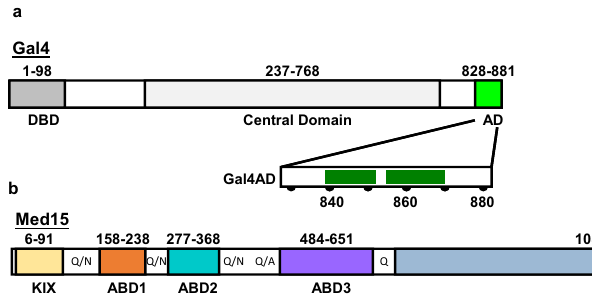
Fig. 1 Gal4 AD is an IDR that interacts with Gal15 ABDs. a Gal4 consists of a DNA binding and dimerization domain (DBD), a central domain (CD), and a primary activator domain (AD). The expanded view of the AD highlights key hydrophobic Regions 1 and 2 (residues 840 – 851 and 855 – 869, respectively). The DBD is structured upon DNA binding; the CD is sequence predicted to be predominantly helical; the AD is intrinsically disordered and includes a Gal80 binding site. b Med15 consists of four helical activator-binding domains (ABDs) and a C-terminal domain (blue) that is required for incorporation into the Mediator complex. The structured Med15 domains are connected by Q-rich linkers as